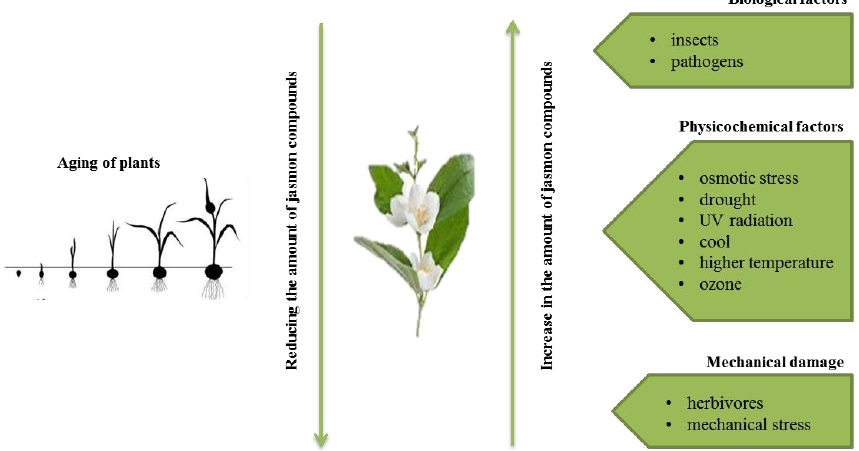
Figure 1. Factors influencing the changes in the levels of jasmonate compounds in the plant.